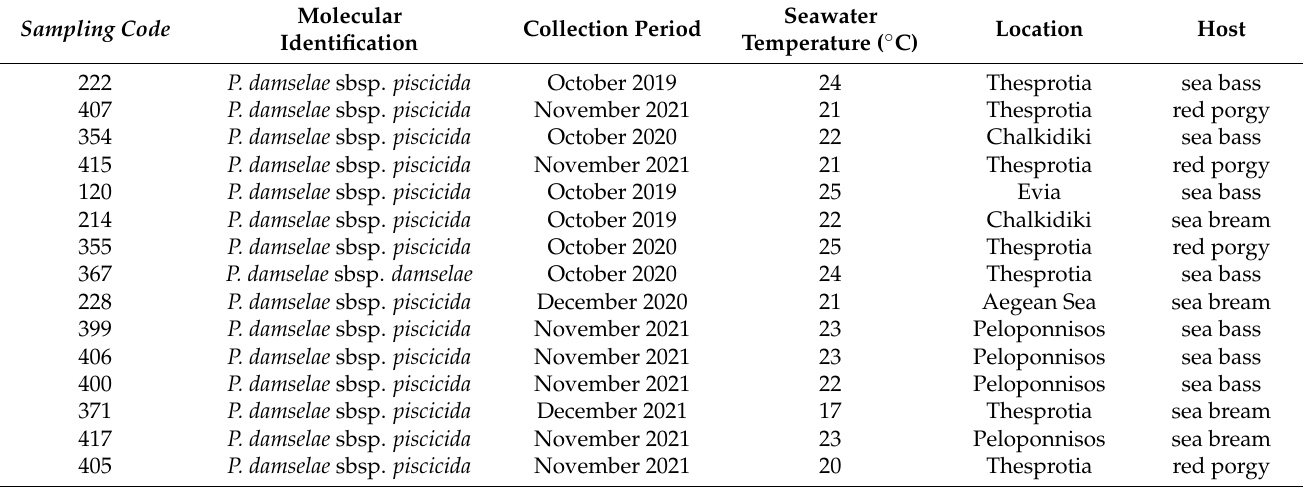
Table 1. Code, identification, seawater temperature, location, host, and collection period of the isolated